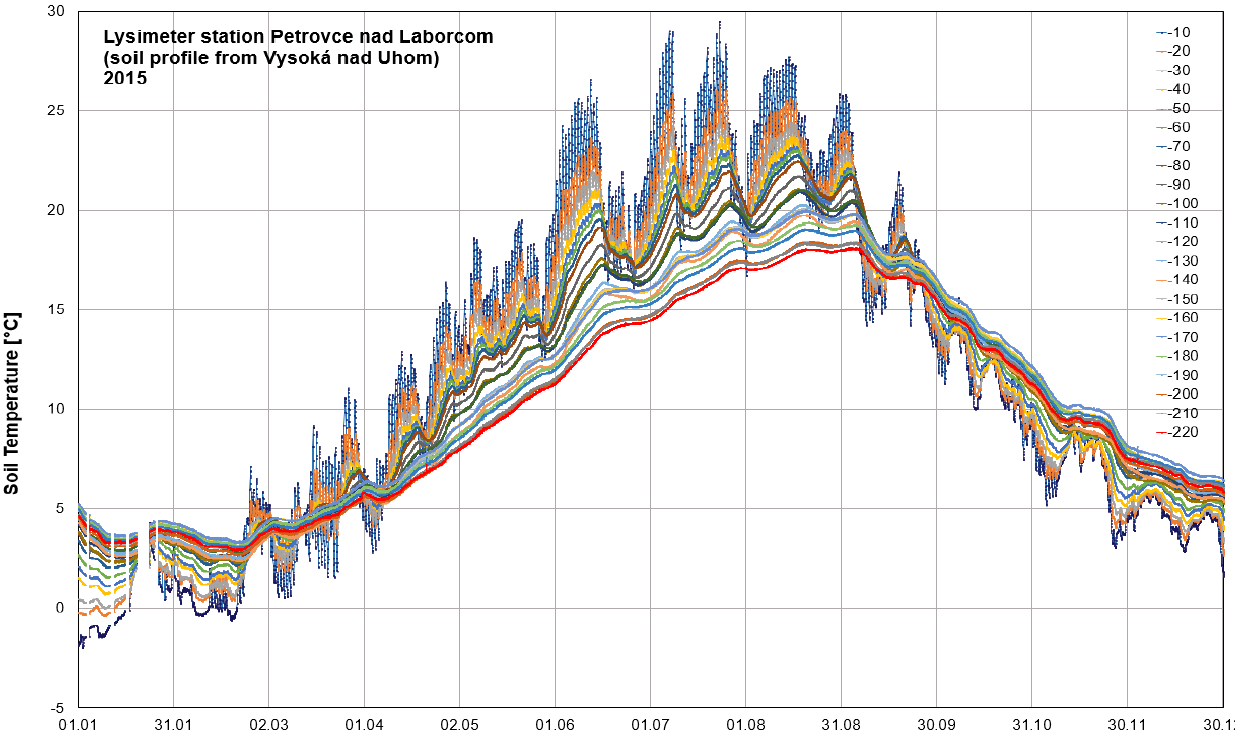
Figure 3. Measured soil temperatures at 22 depths at the lysimeter station in Petrovce n. Laborcom in 2015 at hourly intervals.